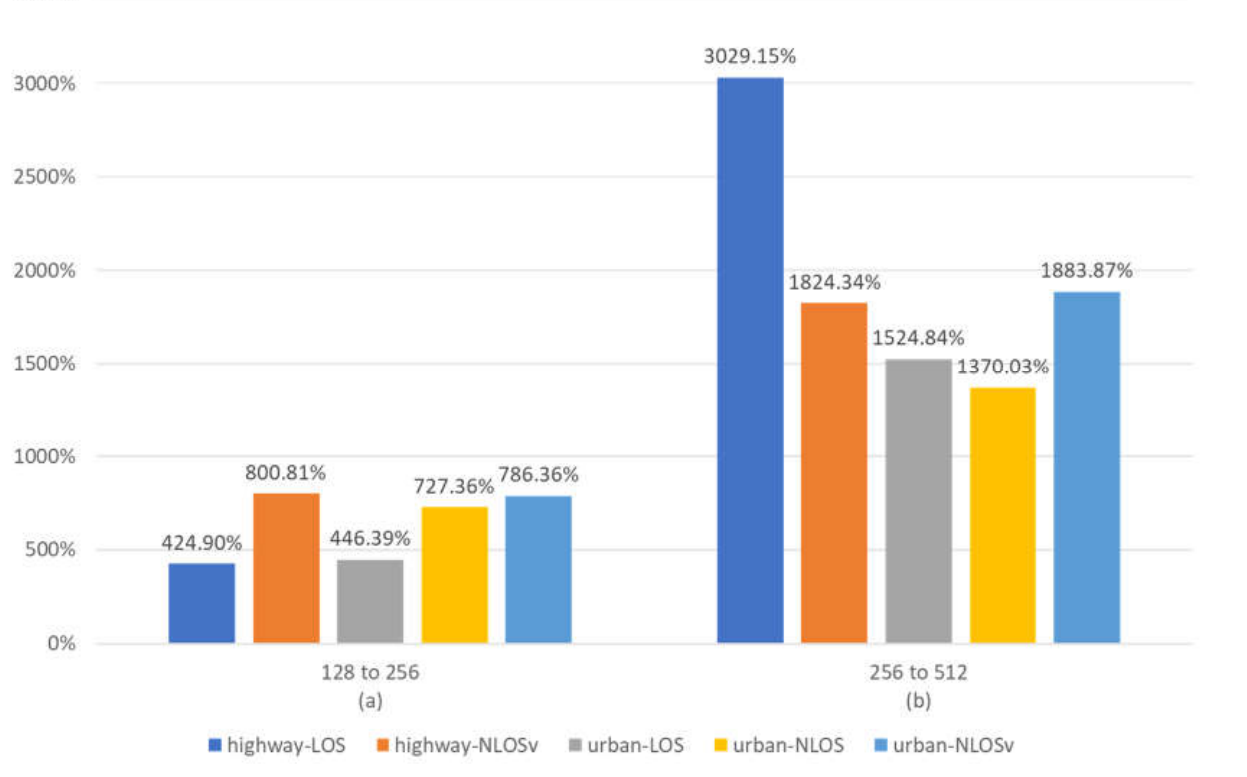
Figure 5. Mean percentage BER improvement vs. frame length for maxlogBCJR and for all simulated scenarios. ( a ) BER improvement when the frame length changes from 128 to 256 bits. ( b ) BER improvement when the frame length changes from 256 to 512 bits.